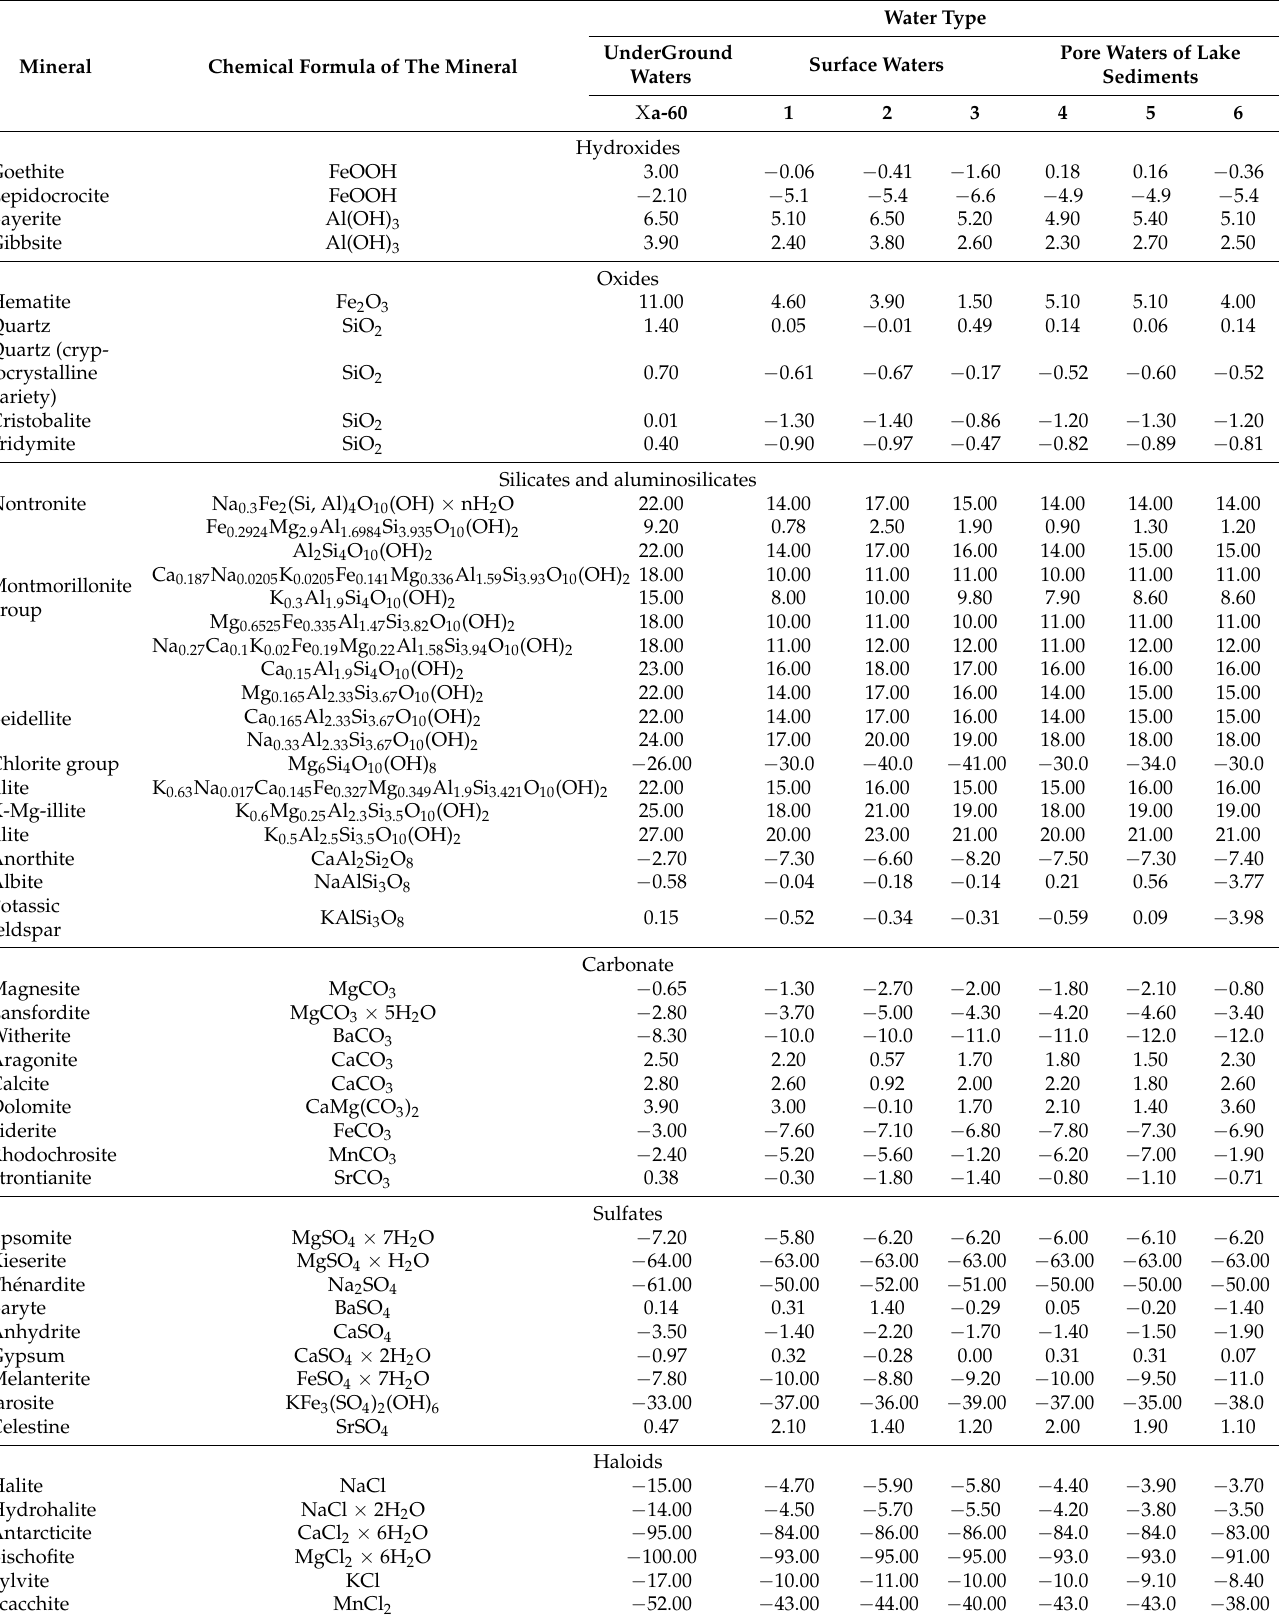
Table 3. The degree of saturation of various water types in Lake Taloe to minerals (disequilibrium indices).